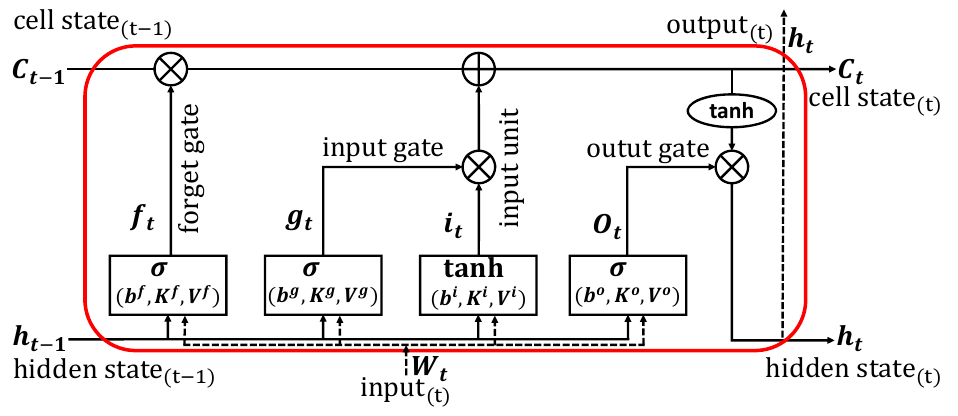
Figure 3. LSTM diagram at a time t